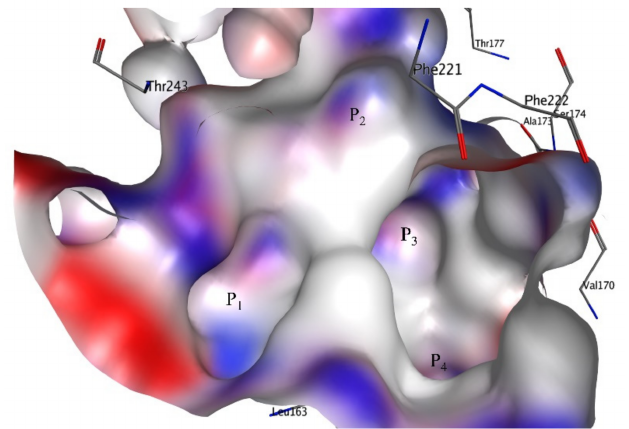
Figure 10. Binding site of 5-HT6 used in the present work. Table 3. The molecular docking score and Ki (nM) for ten molecules with the highest and lowest molecular docking